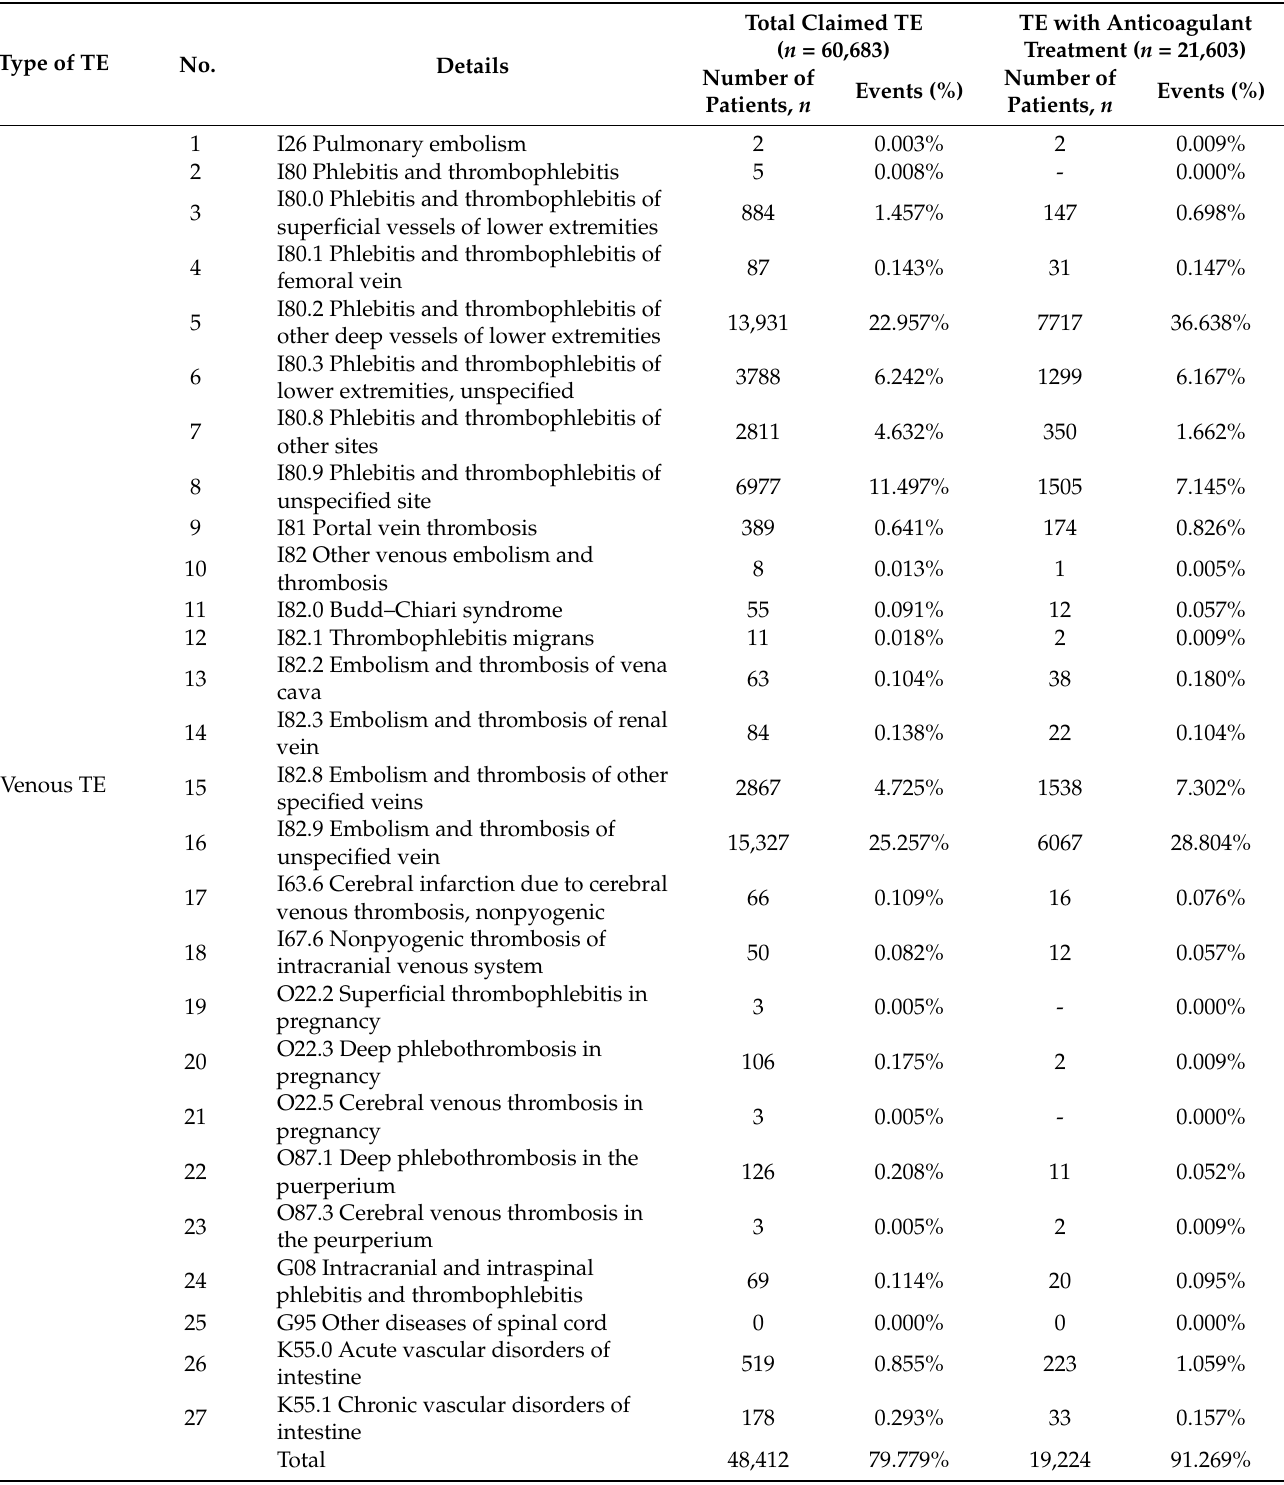
Table 3. Type of TE within 6 months from the date of each surgery.